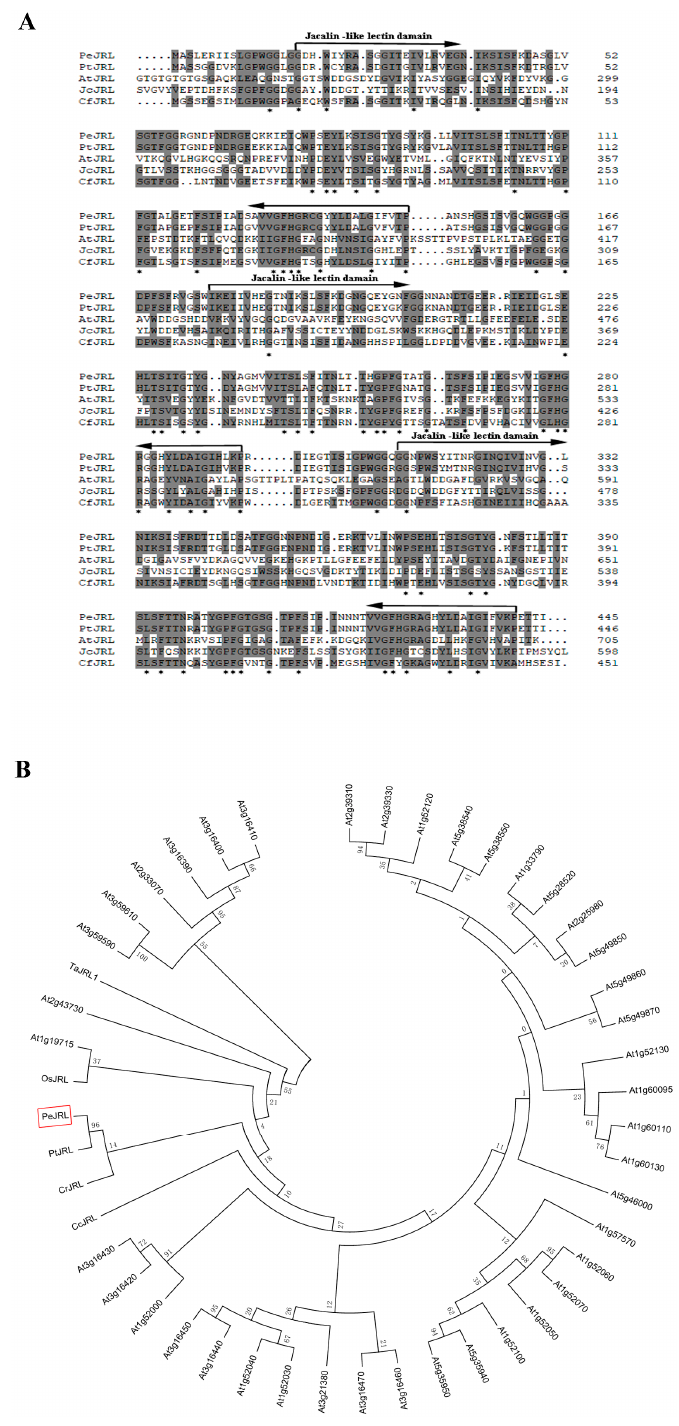
Figure 2. Comparative analysis of PeJRL proteins in different plant species. ( A ) Multiple sequence alignment of PeJRL with JRLs from other species. The JRL sequences are deduced from Populus trichocarpa ( PtJRL , XP_024444915.1), Arabidopsis thaliana ( AtJRL , AT3G16460), Jatropha curcas ( JcJRL , XP_020533220.1), and Cephalotus follicularis ( CfJRL , GAV61504.1). Grey shading and asterisks indicate conserved and invariant amino acid residues, respectively. Three jacalin-like lectin domains are shown with arrows. ( B ) Phylogenetic relationships between PeJRL and other JRL family members from different species. The phylogenetic tree was constructed with the neighbour-joining method using MEGA 5.2. Bootstrap values of 1000 replicates. At, Arabidopsis thaliana ; Cc, Castanea crenata ; Cr, Cycas revolute ; Os, Oryza sativa ; Pe, Populus euphratica ; Pt, Populus trichocarpa ; Ta, Triticum